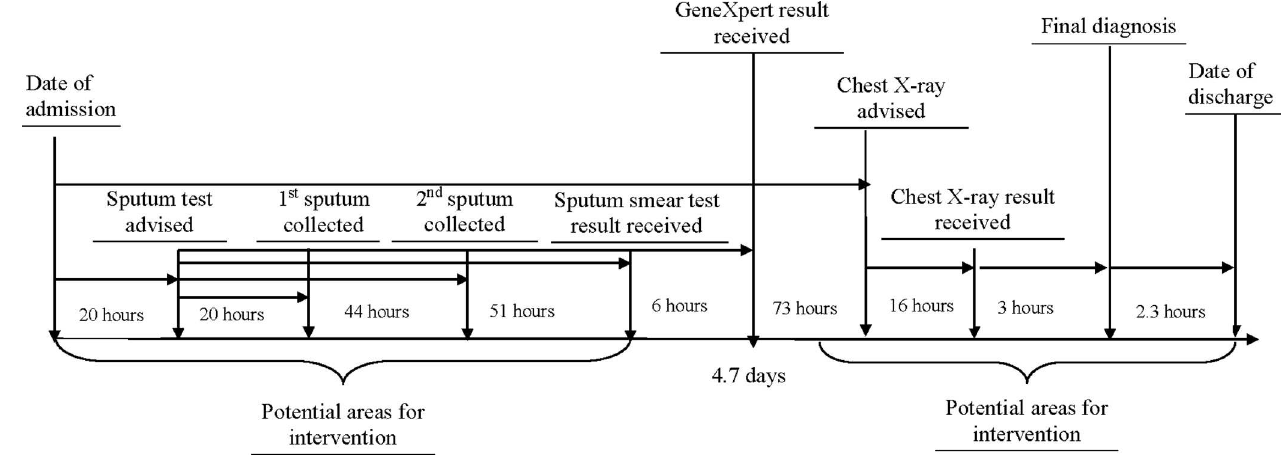
Fig 2. Median time intervals between different activities from TB patient admission to discharge in two tertiary care hospitals, 2017–19.